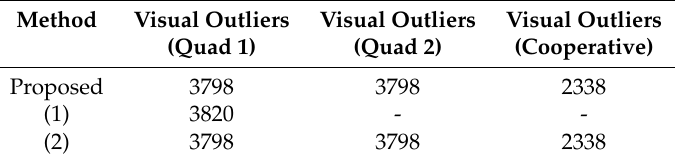
Table 4. Number of outliers introduced into the SLAM